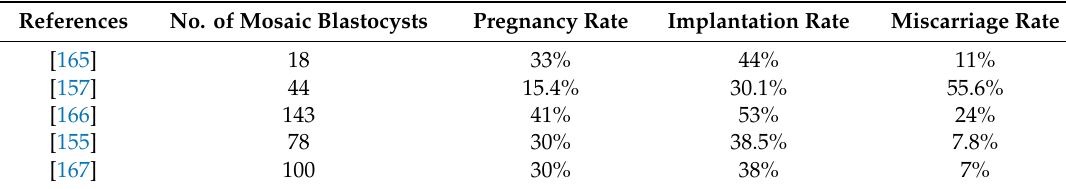
Table 1. Clinical outcomes after transfer of mosaic